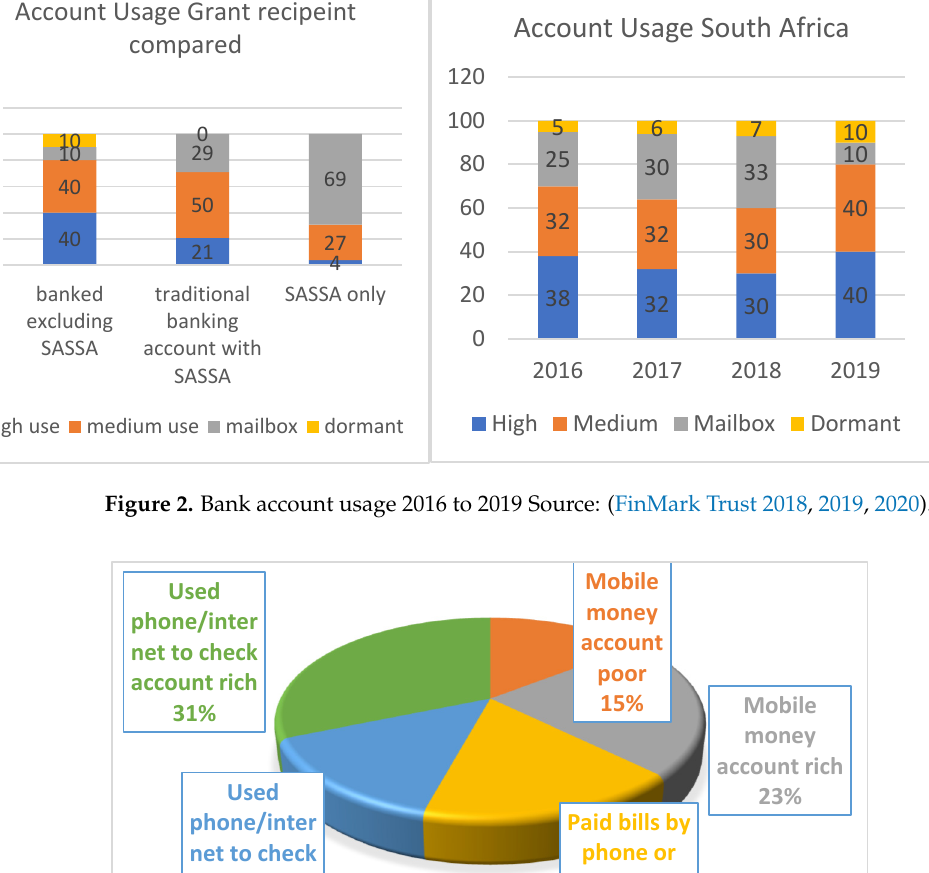
Figure 2. Bank account usage 2016 to 2019 Source: (FinMark Trust 2018, 2019, 2020).